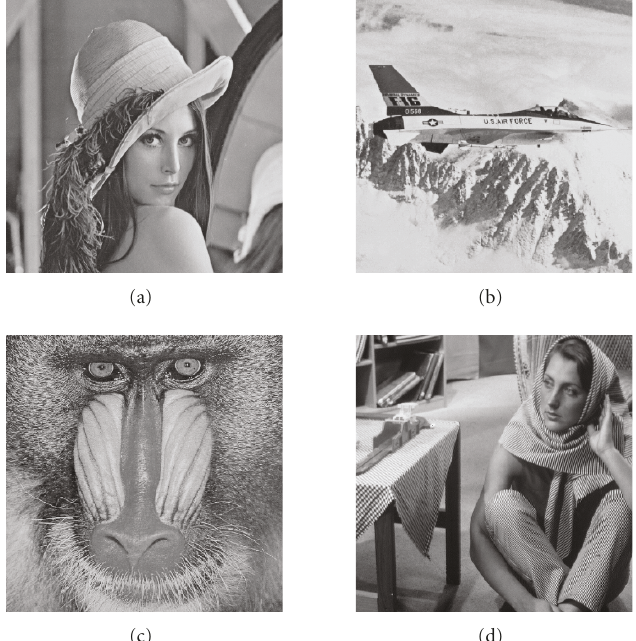
Figure 5: The watermarked images of Figure 4: (a) Lena (W) (PSNR = 44.14 dB), (b) Jet (W) (PSNR = 44.13 dB), (c) Baboon (W) (PSNR = 44.15 dB), and (d) Barbara (W) (PSNR = 44.15 dB).